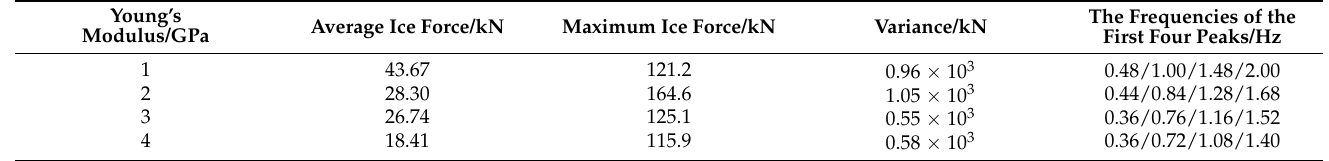
Table 11. Statistics of ice force under different Young’s modulus ( E i ).